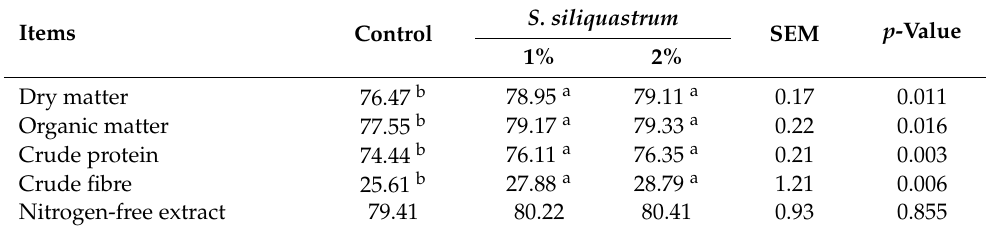
Table 4. Effect of S. siliquastrum dietary treatment on nutrient digestibility in Japanese quails.